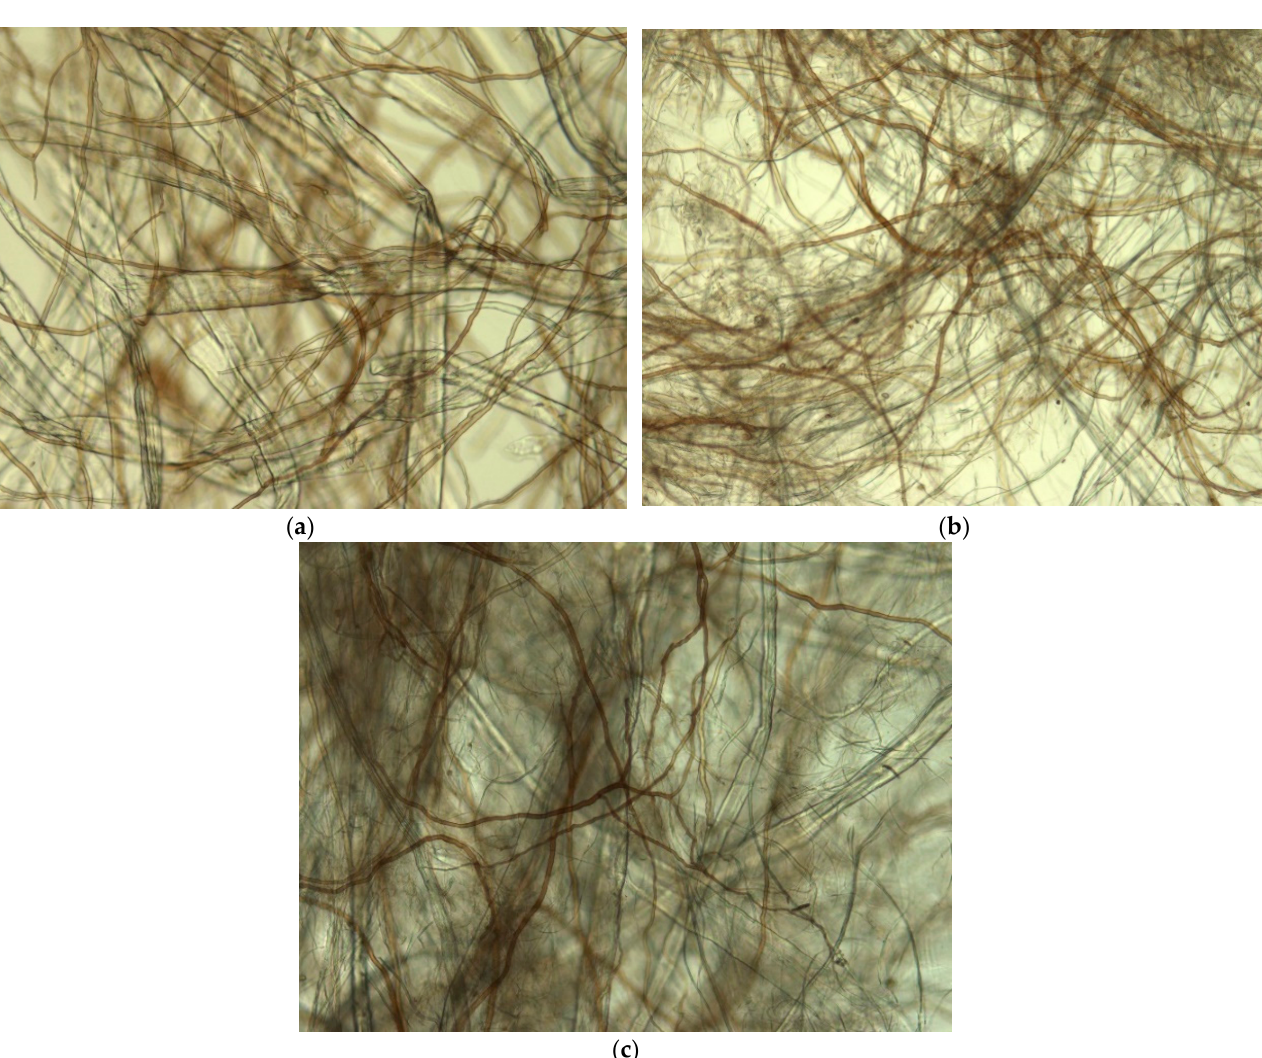
Figure 1. Microstructure (light microscopy, magnification 200×) of the composite materials: ( a ) KF FF; ( b ) HF FF; ( c ) HF KF FF.